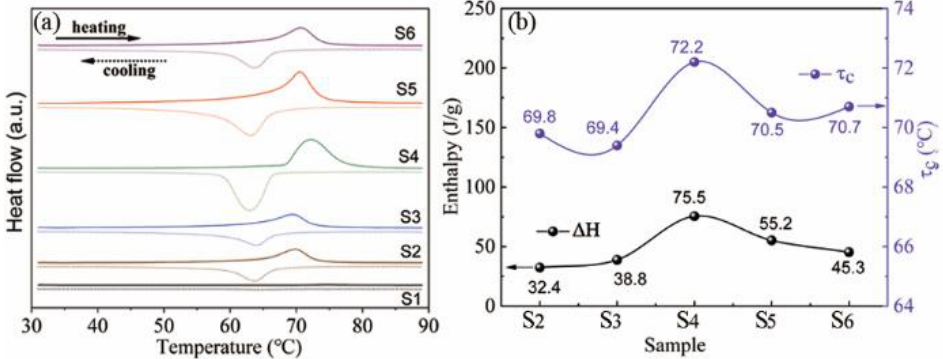
Figure 4. ( a ) DSC data of samples with different oxalic acid concentrations; ( b ) phase-change enthalpy (ΔH) and transition temperature ( 𝜏 𝑐 ) versus hydrothermal duration.